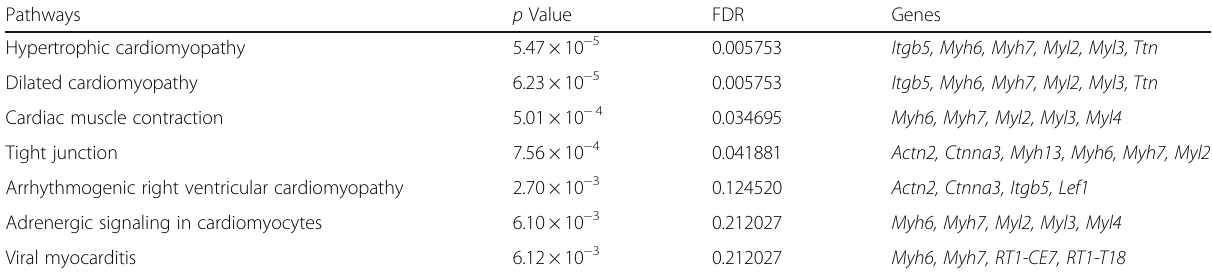
Table 2 Top pathways associated with down-regulated differentially expressed genes between the EXD group and OVX group Pathways p